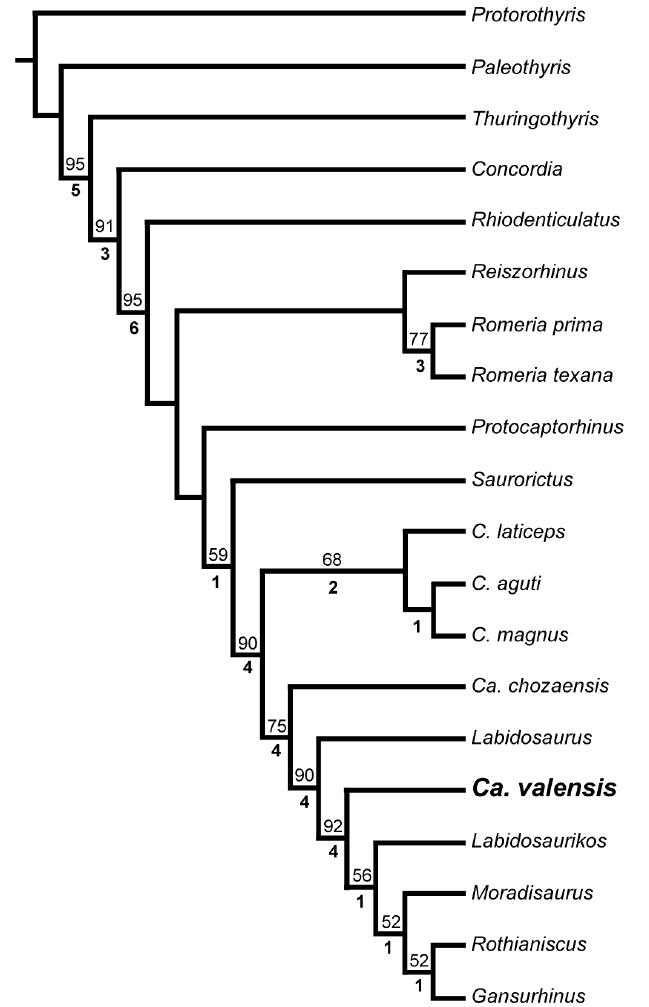
Figure 6. Single most parsimonious tree (TL = 147; CI = 0.633; RI = 0.779; RCI = 0.493) resulting from the updated character codings for Captorhinikos valensis based on new Bally Mountain specimens. Numbers above the nodes indicate bootstrap support. Numbers below nodes indicate decay